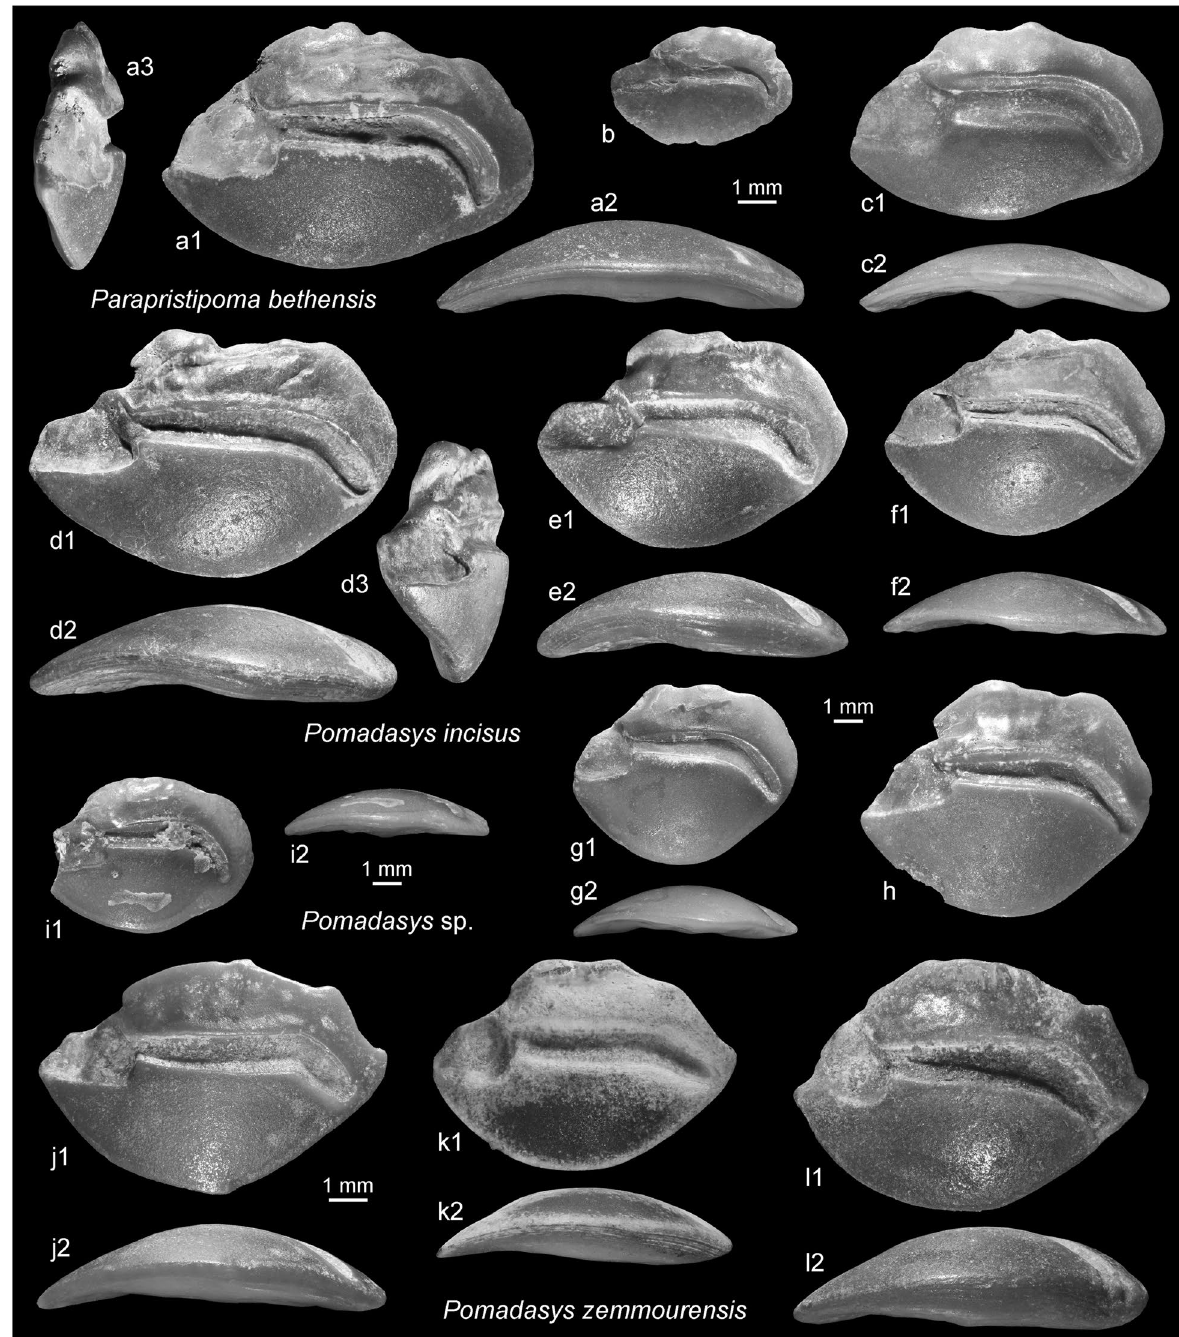
Fig. 23 Haemulidae. a – c Parapristipoma bethensis n. sp., Dar bel Hamri, Zanclean, a holotype, SMF PO 101.285, b – c paratypes, SMF PO 101.286. d – h Pomadasys incisus (Bowdich, 1825), SMF PO 101.241 ( d – g reversed), Dar bel Hamri. i , Pomadasys sp. SMF PO 101.244, Dar bel Hamri. j – l ,